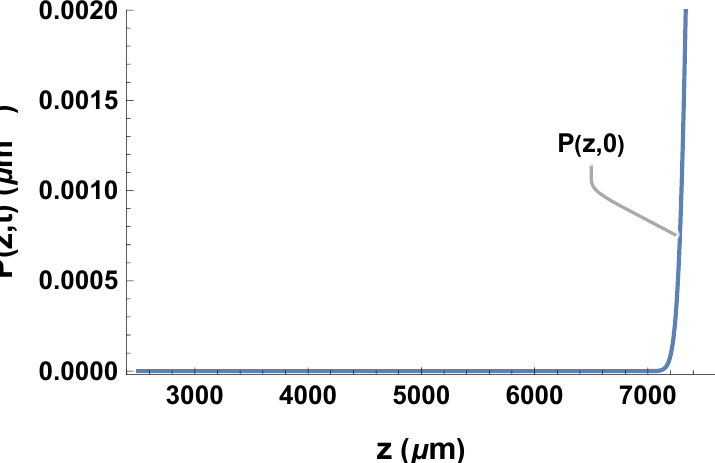
Figure 8. Simulation of MNPs probability density function, P ( z , t ) , in both mucus and corn syrup after 24 h from simulation start. In the vertical direction, diffusion, gravity, and the magnetic pulling force can have effects on P ( z , t ) . Here, P ( z ,0 ) is not affected by passage of time. MNPs are not pulled from their initial positions because individual MNPs experience very little pulling force when they do not form